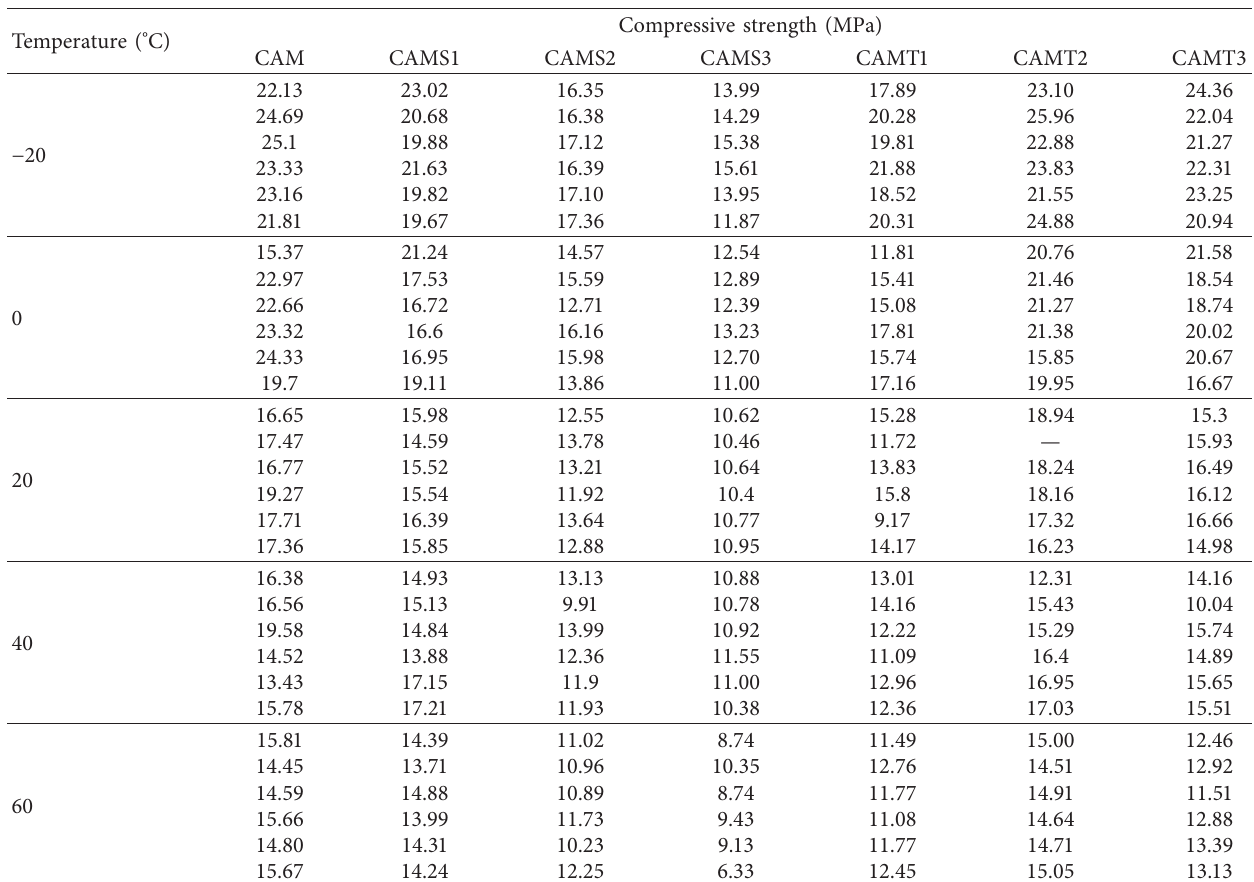
Table 7: Compressive strength of CAM with and without